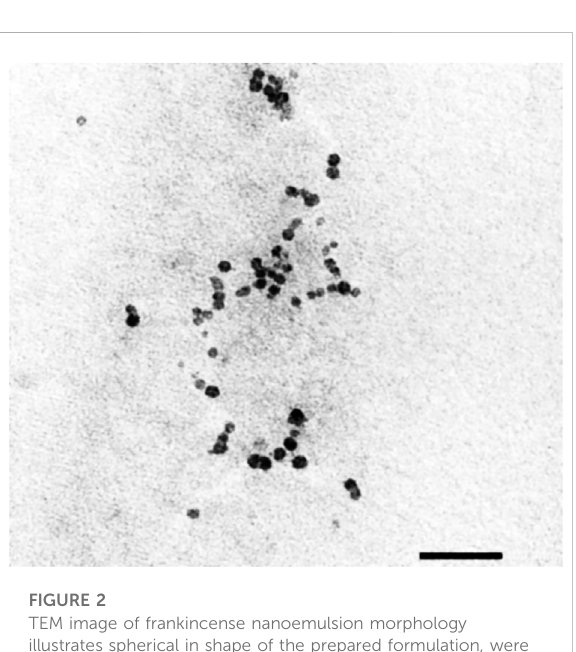
FIGURE 2 TEM image of frankincense nanoemulsion morphology illustrates spherical in shape of the prepared formulation, were taken at ×25,000 magni fi cation (×25